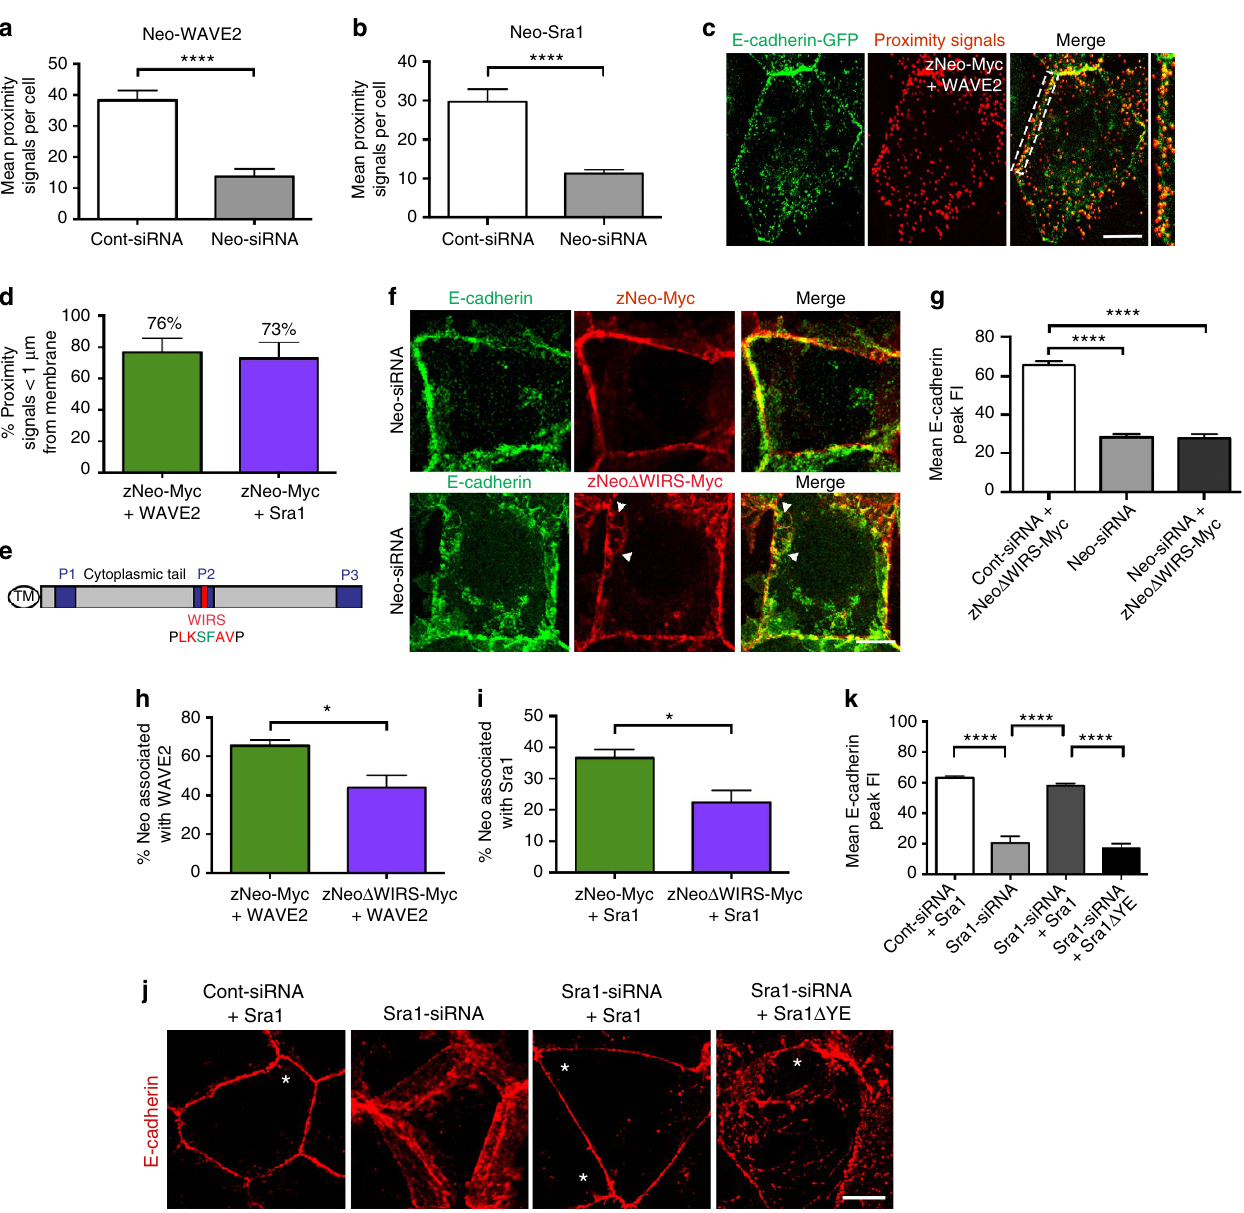
Figure 5 | The WIRS domain in Neogenin interacts with the WRC at the AJ. The Duolink proximity assay revealed that Neogenin associated with WAVE2 ( a ) and Sra1 ( b ) in Caco-2 cells ( n ¼ 3 experiments, mean ± s.e.m., **** P o 0.0001, Student’s t -test). ( c ) Proximity signals for zNeo-Myc þ WAVE2 (red) were closely associated ( o 1 m m) with the Ecad þ AJ membrane (green). ( d ) Percentage of zNeo-Myc þ WAVE2 and zNeo-Myc þ Sra1 proximity signals tightly associated ( o 1 m m) with the AJ relative to total cellular zNeo-Myc þ WAVE2 or zNeo-Myc þ Sra1 proximity signals, respectively ( n 4 27 cells). ( e ) Schematic of Neogenin cytoplasmic domain: WIRS domain (red); mutated amino acids in the WIRS domain (green); and subdomains P1–3 (blue). ( f ) Junctional integrity (Ecad, green) was rescued by zNeo-Myc (upper panel, red) but not by the WIRS mutant (zNeo D WIRS-Myc, lower panel, red, arrowheads). ( g ) Line-scan analysis: mean Ecad peak fluorescence intensity (FI) in cells expressing Neo-siRNA and zNeo D WIRS-Myc ( n ¼ 150 junctions, mean ± s.e.m., **** P o 0.0001, one-way analysis of variance (ANOVA), Dunn’s post hoc test). ( h , i ) The extent of association between zNeo D WIRS-Myc and WAVE2 or Sra1 was significantly reduced compared with that of zNeo-Myc ( n 4 26 cells, mean ± s.e.m., * P o 0.05, Student’s t -test). ( j ) Wild-type Sra1 but not Sra1 D YE rescues AJ integrity in Sra1-siRNA cells (Ecad, red; asterisk represents IRES-GFP þ cell). ( k ) Line-scan analysis: mean Ecad peak FI in cells expressing Sra1-siRNA and Sra1 or Sra1 D YE ( n ¼ 150 junctions, mean ± s.e.m., **** P o 0.0001, one-way ANOVA, Dunn’s post hoc test). Scale bars, 7 m m ( c , f , j ).